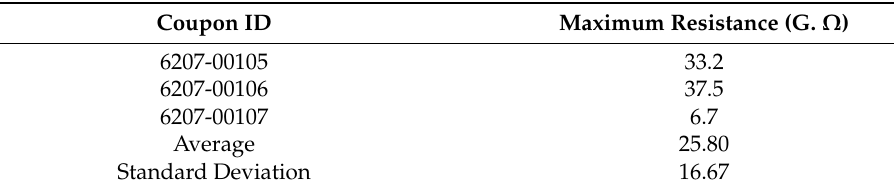
Figure 10. Multifunctional electro-tensile properties of specimens: ( a ) 6207-00105; ( b ) 6207-00106; ( c ) 6207-00107.